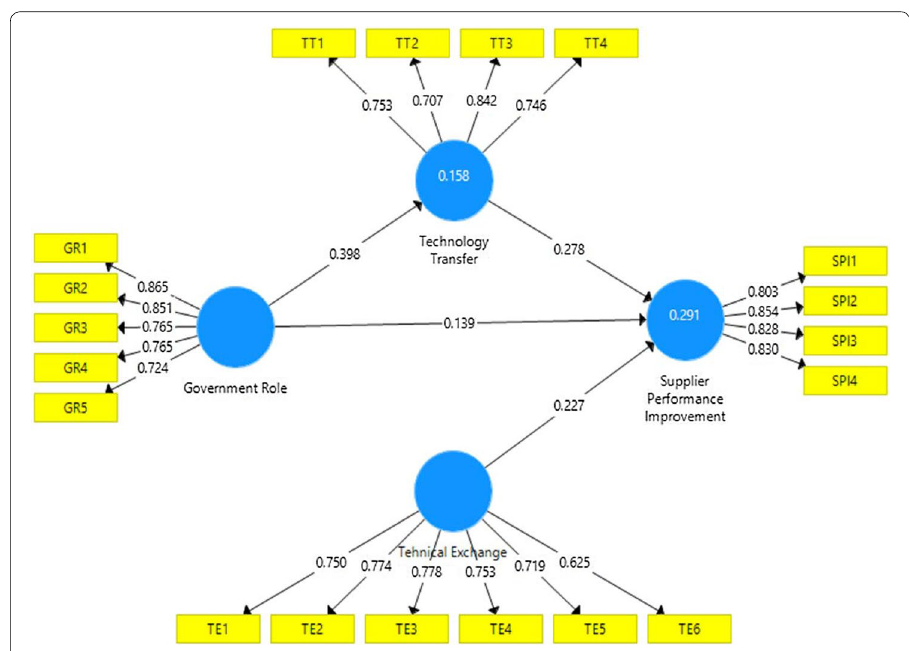
Fig. 6 Result. Source : Author Data, Smart PLS